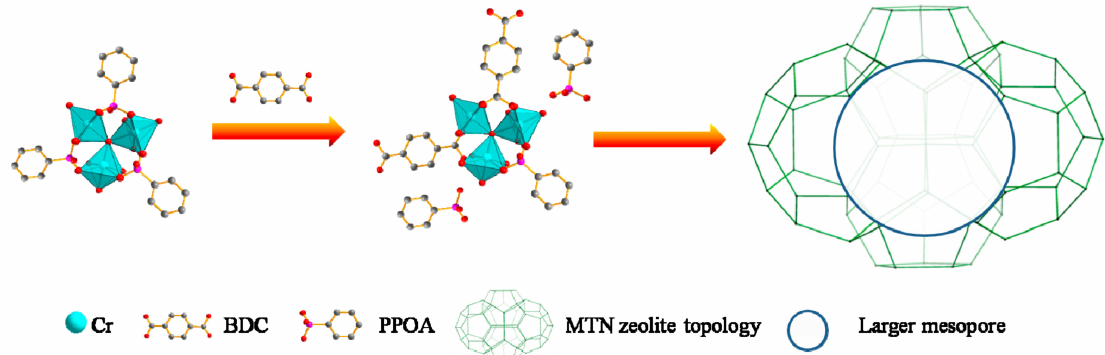
Scheme 1. Schematic illustration of the synthesis of hierarchical MIL-101(Cr) with phenylphosphonic